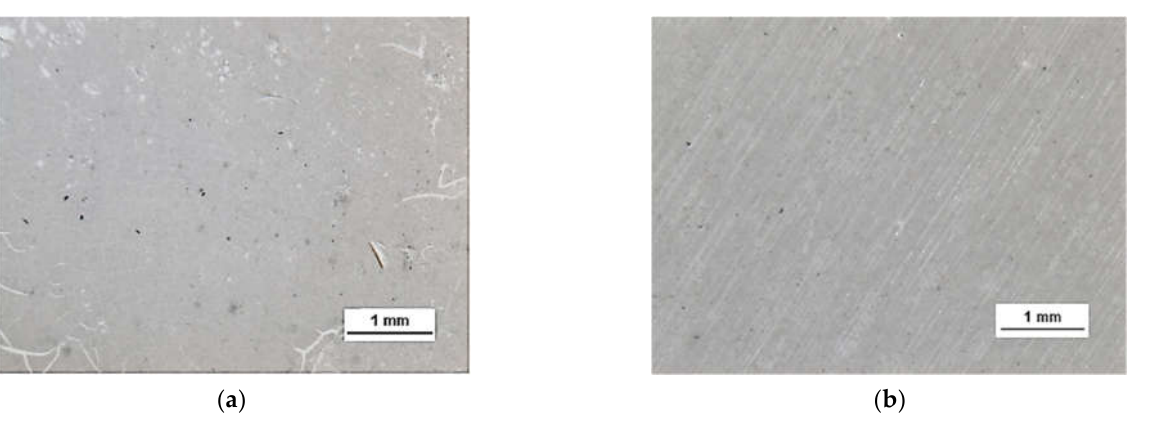
Figure 8. Microscope images of the surface of graphene: ( a ) HSMG ® and ( b ) CVD, transferred to Al 2 O 3 ceramics etched with O 2 plasma using RF PACVD method.